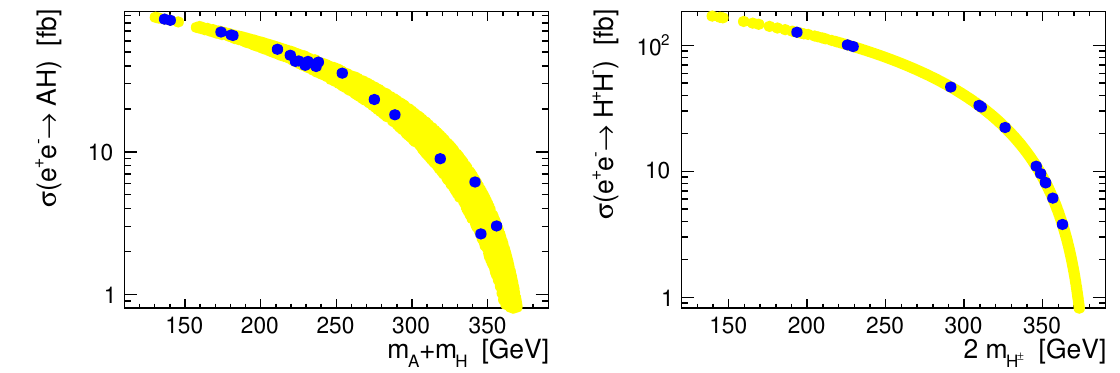
Figure 1 . Leading-order cross-sections for neutral (left) and charged (right) inert scalar production, e + e (cid:0) ! HA and e + e (cid:0) ! H + H (cid:0) , for 380 GeV collision energy. The yellow band represents all scenarios selected in the model scan [4] while the blue dots represent the selected benchmark scenarios. Beam energy spectra are not